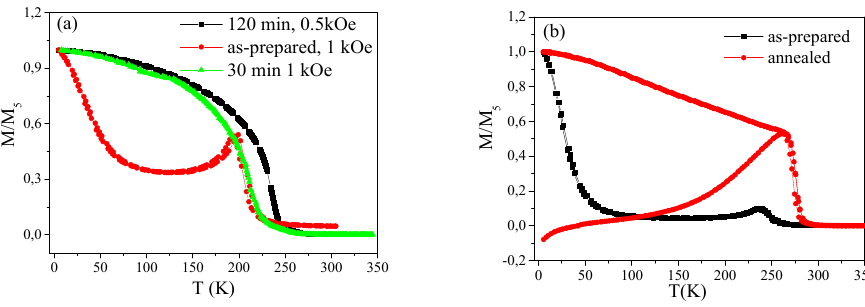
Figure 43. Temperature dependence of M/M 5 measured in as-prepared Ni 50 Mn 35 In 15 glass-coated microwire annealed at 823 K for 30 min and for 120 min ( a ) and in as-prepared and annealed at 823 K for 30 min Ni 42.5 Mn 37.5 In 12.5 Co 7.5 glass-coated microwire ( b ). Reproduced from reference [114], Figure